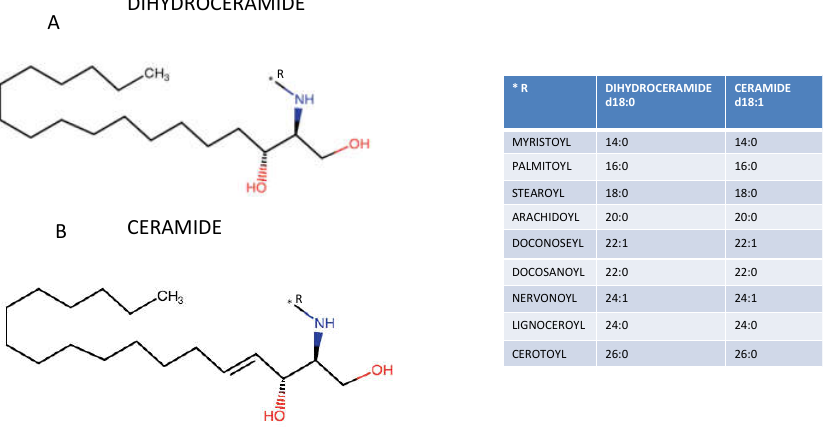
Figure 1. ( A ) Dihydroceramide structure ( B ) Ceramide structure. The table reports the different fatty acids with variable length joined by an amide